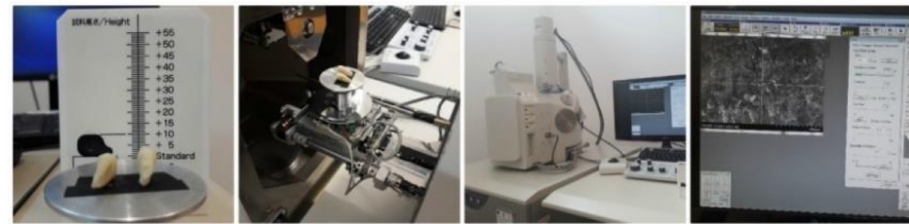
Figure 1. The steps taken to view the samples at